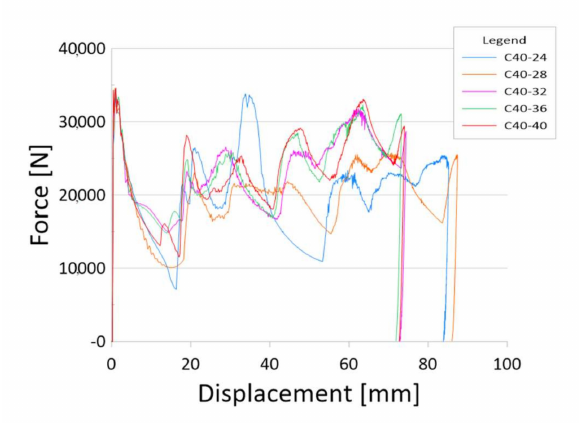
Figure 9. The results for models with a sidewall thickness of 1–2